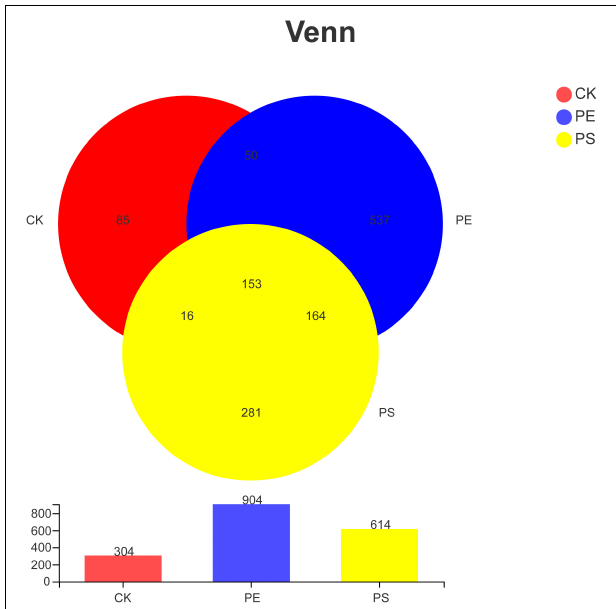
FIGURE 6 | Venn diagram of the number of OTUs in different treatment groups. There are 304 OTUs in the control group, 904 OTUs in the PE group and 614 OTUs in PS group. The three samples share 153 OTUs, accounting for 50.33, 16.92, and 29.92%, respectively.